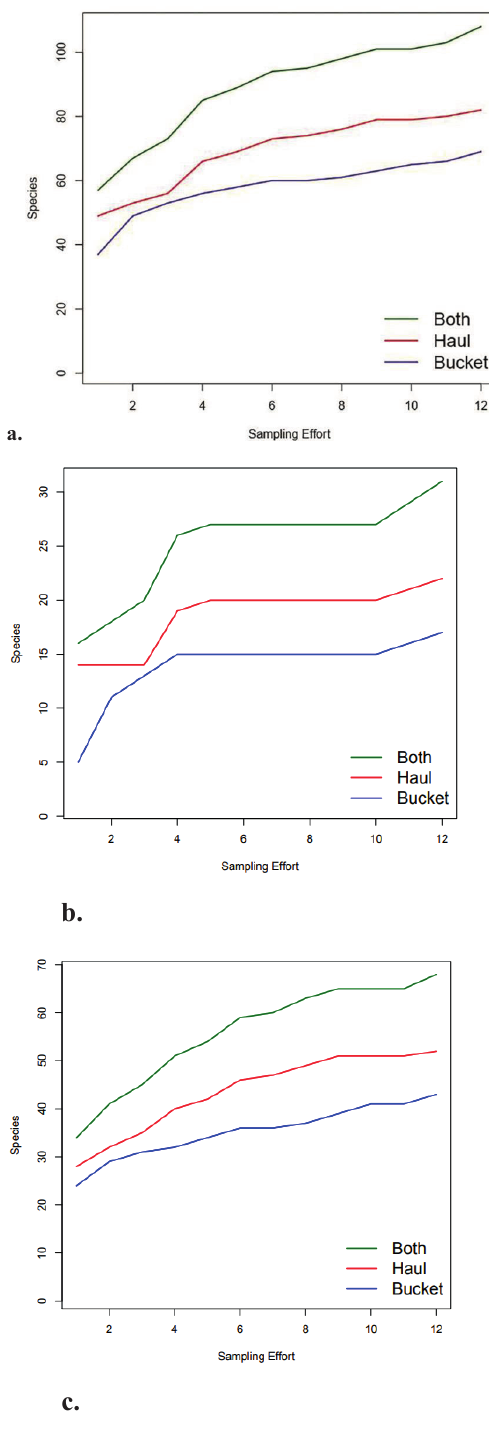
Figure 2 - The collector’s curves for vertical haul (red), bucket (blue) and both-intersection (green). a. all groups, b. cladocerans, c.